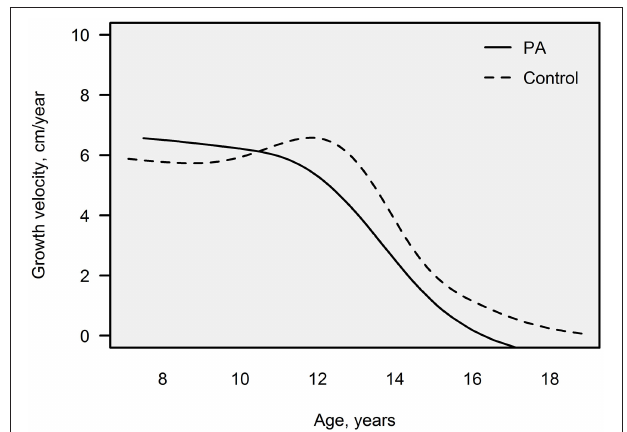
FIGURE 2 | Growth velocity-for-age, illustrated as trend lines for the PA ( n = 12) and control females ( n = 23) whose detailed growth data were available. Growth velocity (cm/year) was assessed by calculating the change of height derived from a combination of growth data by the investigator and school health care providers. PA, premature